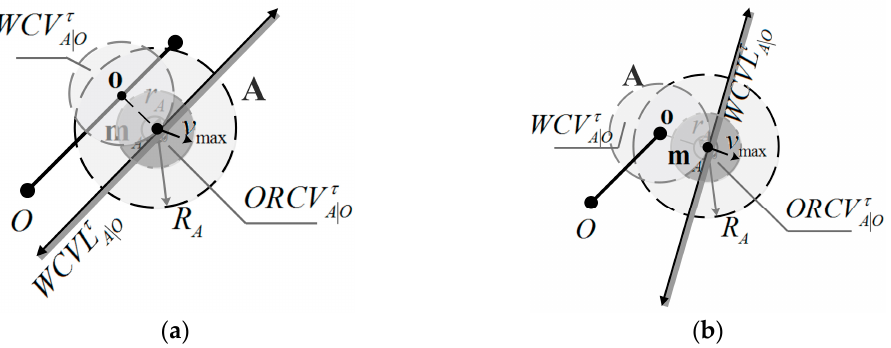
Figure 7. Two cases of visual display of UAV A , obstacle O and ORCV τ coverage point o is on the edge of the segment O ; ( b ) The most weak coverage point o is the endpoint of the segment O .